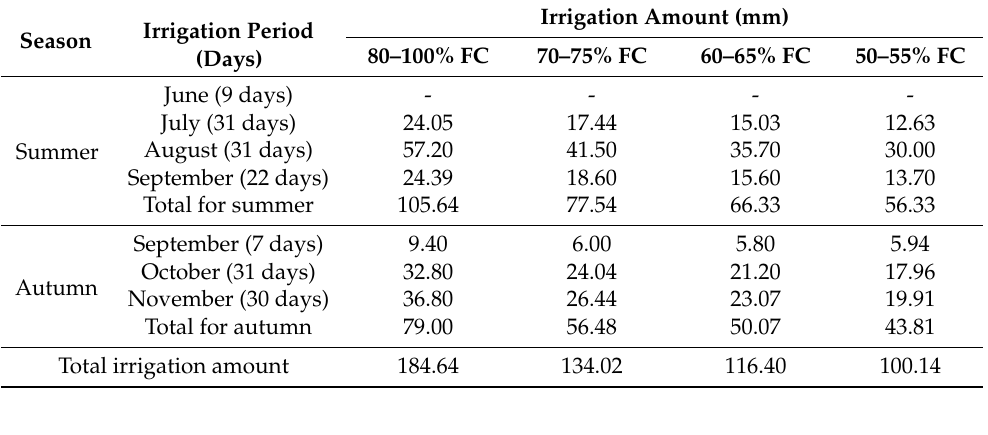
Table 3. Irrigation water supplied for mandarin in different seasons in 2021.